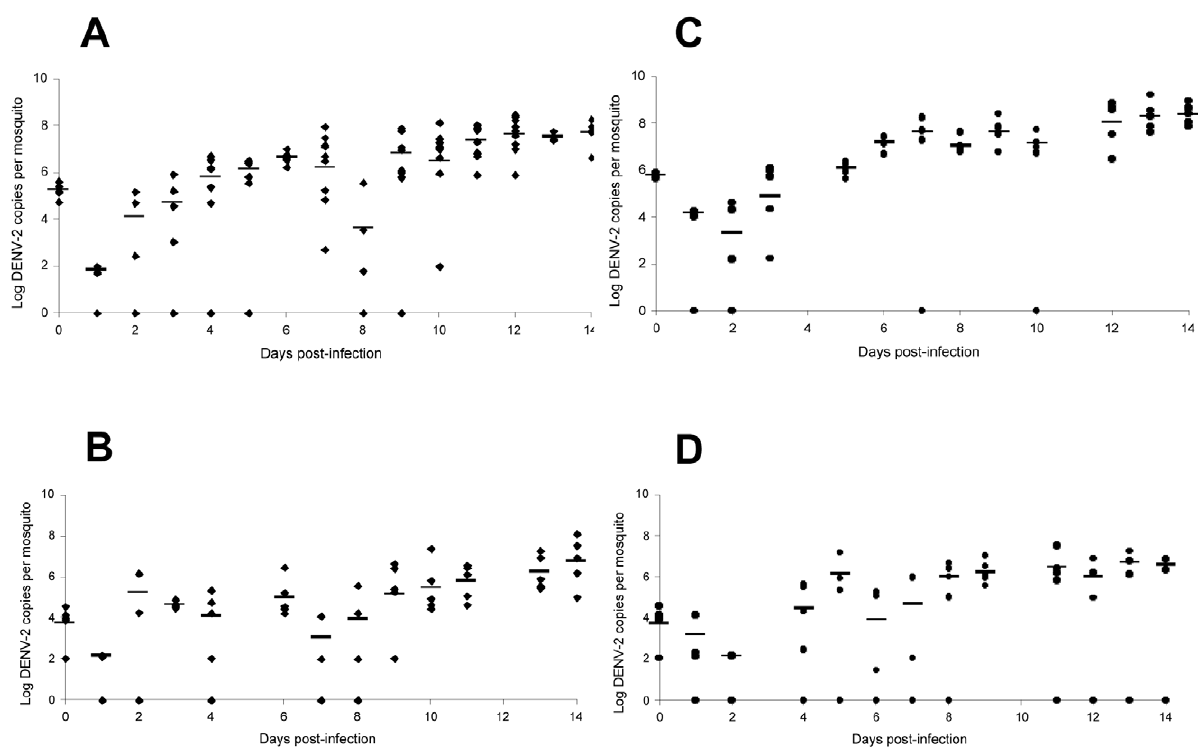
Figure 1. Viral dynamics in Wolbachia -infected and Wolbachia -uninfected Ae. albopictus after exposure to DENV-2. Batches of mosquitoes were exposed to an infectious blood-meal at two viral titers: 10 7 FFU/mL (A, C) and 10 5 FFU/mL (B, D). Every day, 4–9 mosquitoes were killed for RNA extraction and the number of DENV-2 genome copies was determined by qRT-PCR using primers targeting the C gene. Lines indicate the median. Significance was determined using the Mann-Whitney test (p ,